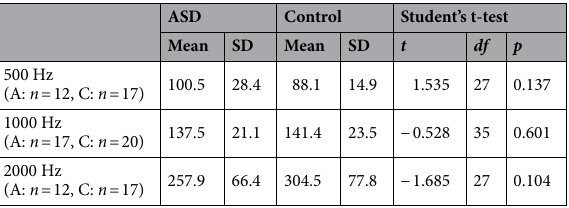
Table 2. Summary of statistics of ERBs (in hertz) for ASD and control groups at each center frequency.